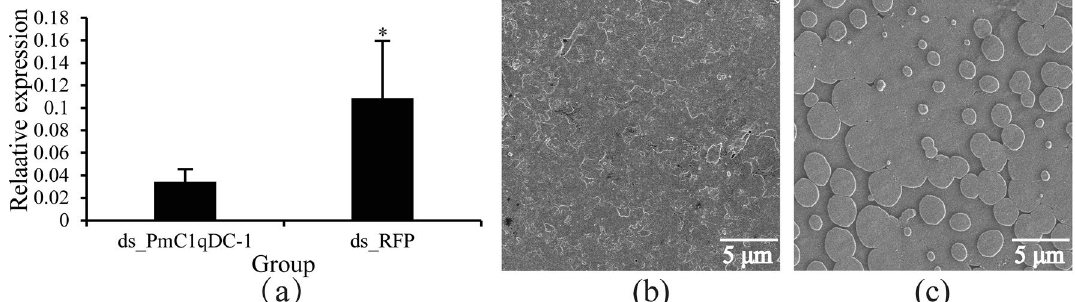
Figure 7. Effect of PmC1qDC-1 on shell formation by RNA interference (RNAi). ( a ) Relative expression of PmC1qDC-1 at the mantle pallial after RNAi. ( b ) Inner surface microstructure of the nacre layer in the